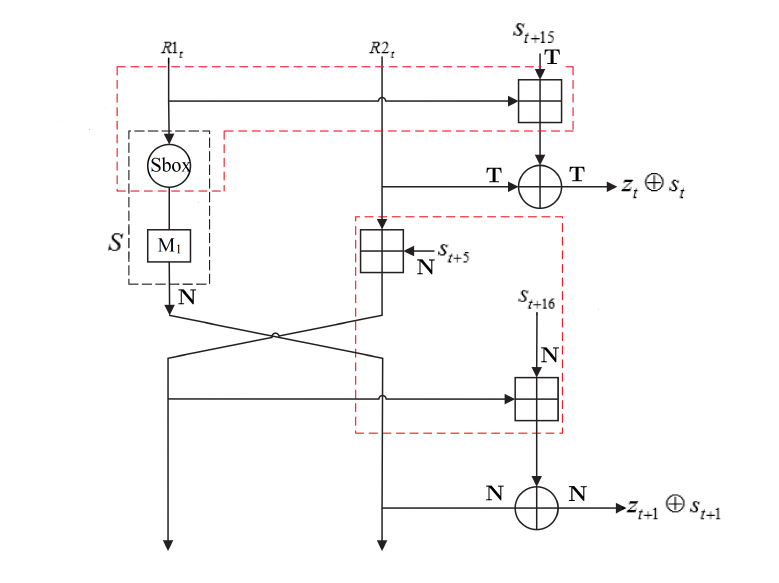
Figure 4: The two-round byte-wise linear approximations for the FSM of SNOW